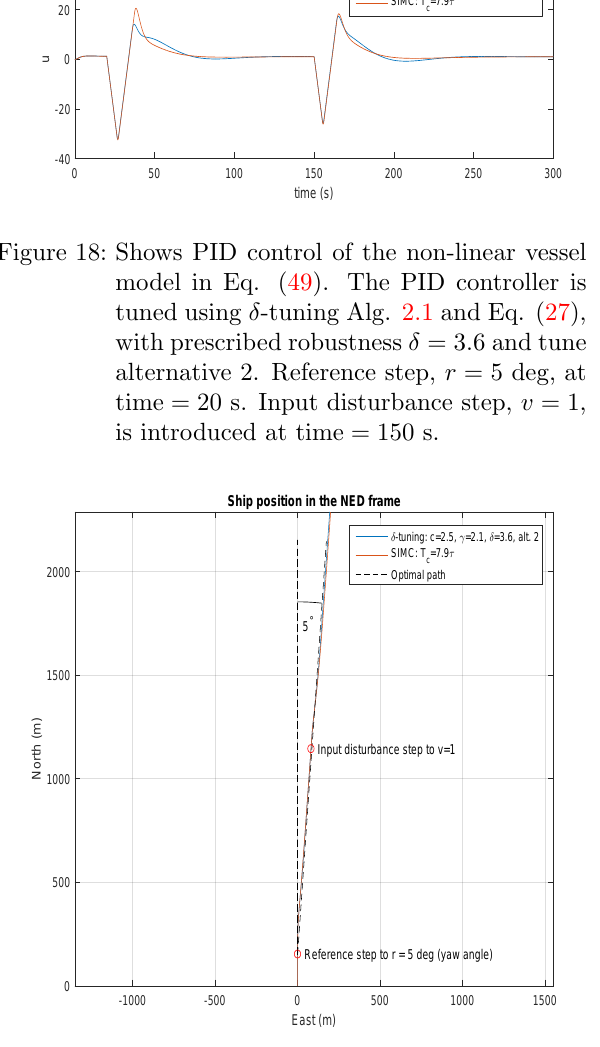
Figure 19: Shows PID control of the non-linear vessel model in Eq. (49). The PID controller is tuned using δ -tuning Alg. 2.1 and Eq. (27), with prescribed robustness δ = 3 . 6 and tune alternative 2. Reference step, r = 5 deg, at time = 20 s. Input disturbance step, v = 1, is introduced at time = 150 s.